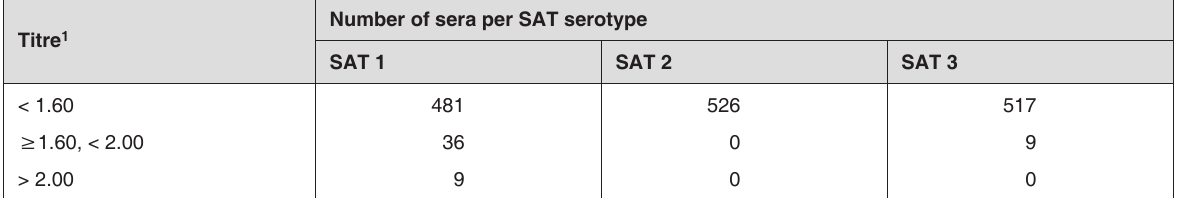
TABLE 4 Distribution of FMD antibody titres by SAT serotypes of FMD virus in indigenous Tswana goats in northwestern Botswana